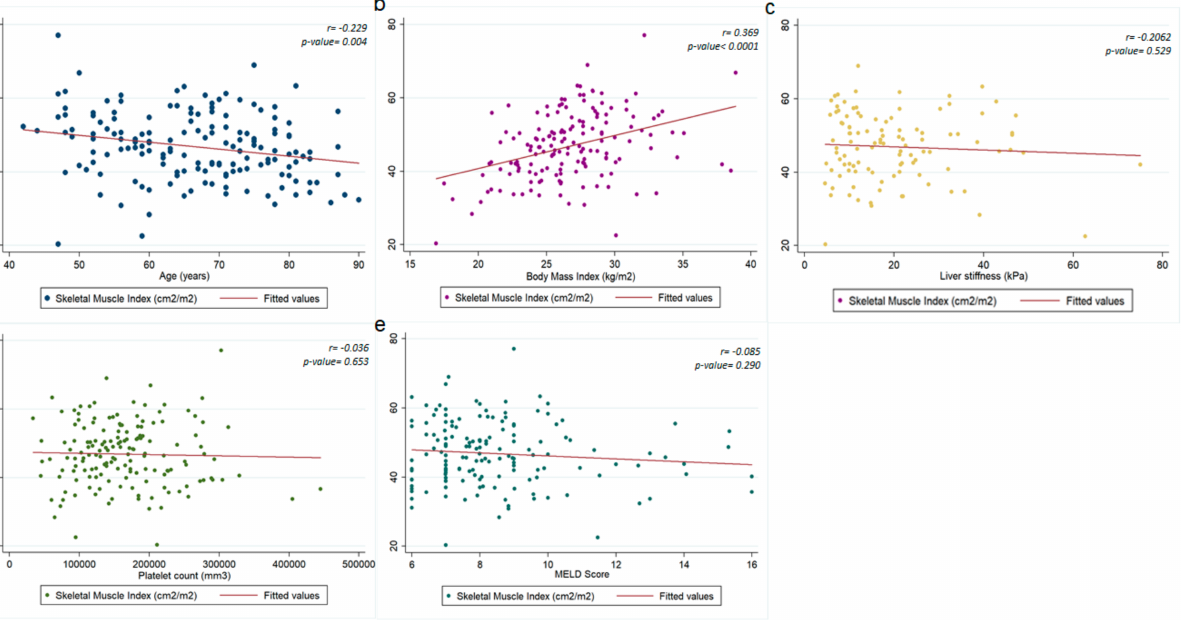
Figure 2. Correlation between sarcopenia by skeletal muscle index (SMI) and: ( a ) age, ( b ) body mass index (BMI), ( c ) liver stiffness measurement (LSM), ( d ) platelet count and ( e ) Model for end-stage liver disease (MELD). r = Spearman’s